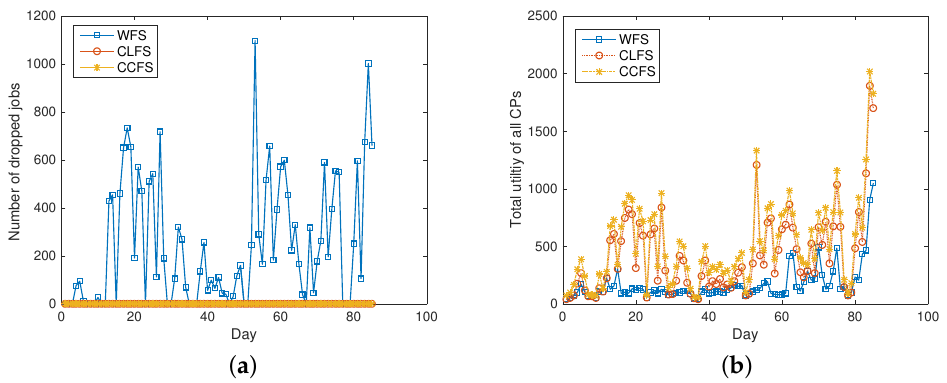
Figure 3. Two-player scenario ( c = 200, k = 1, γ 1 = 200, γ 2 = 1.25). ( a ) The numbers of dropped jobs under the three solutions; ( b ) the utility under the three solutions.